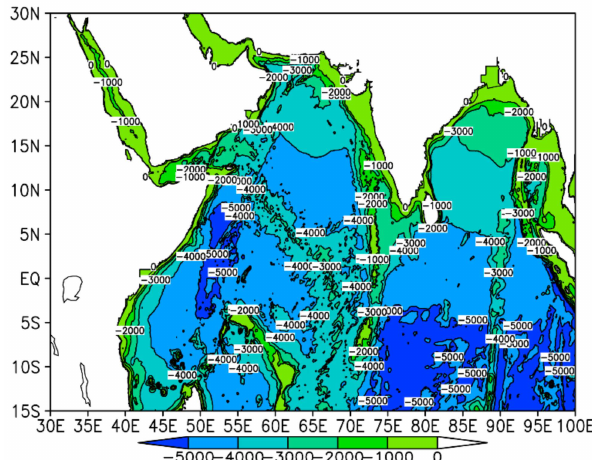
Figure 1. Bathymetry map in the Northern Indian Ocean (unit: